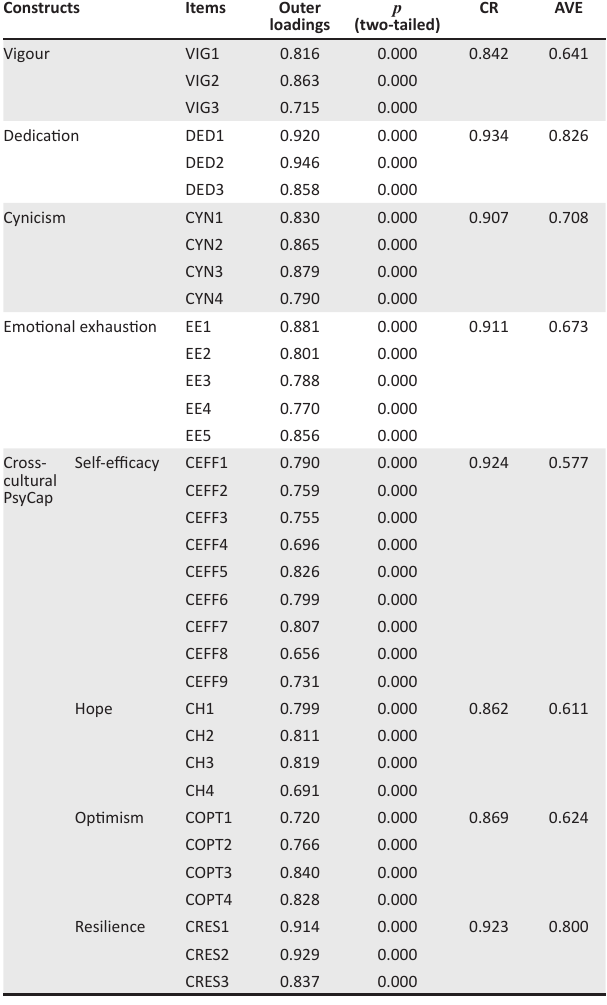
TABLE 1: Results of the original measurement model assessment (all first-order constructs). Constructs